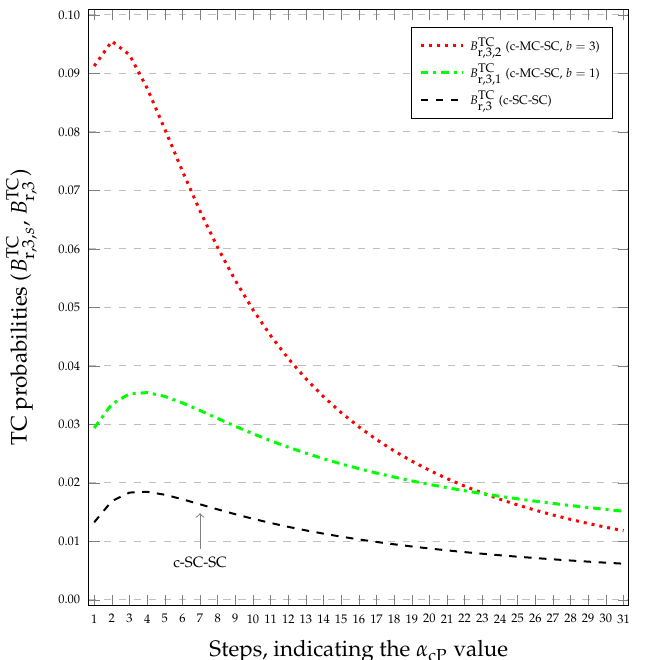
Figure 6. TC probabilities, B TC c-SC-SC).